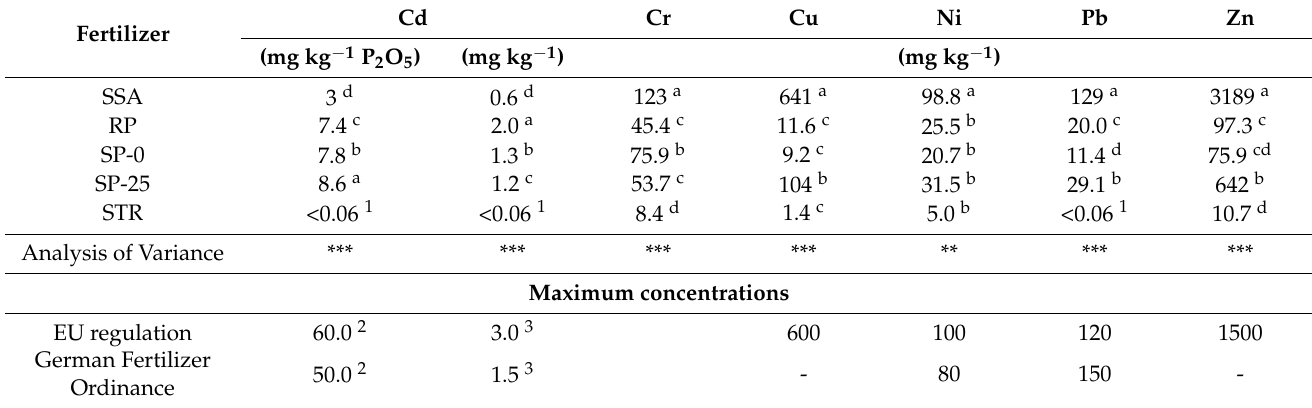
Table 2. Total concentrations of cadmium (Cd), chromium (Cr), copper (Cu), nickel (Ni), lead (Pb), and zinc (Zn) in dry matter (mg kg − 1 ) (unless otherwise noted) of the tested fertilizers and designated maximum concentrations of above- mentioned element in fertilizers according to the EU regulation and German Fertilizer Ordinance [22,23]. The same letters indicate no significant differences between a pair of fertilizers (Tukey’s HSD test ( α = 0.05)). Analysis of Variance: ** = p ≤ 0.01, *** = p ≤ 0.001. For fertilizer abbreviations, see Table 1.